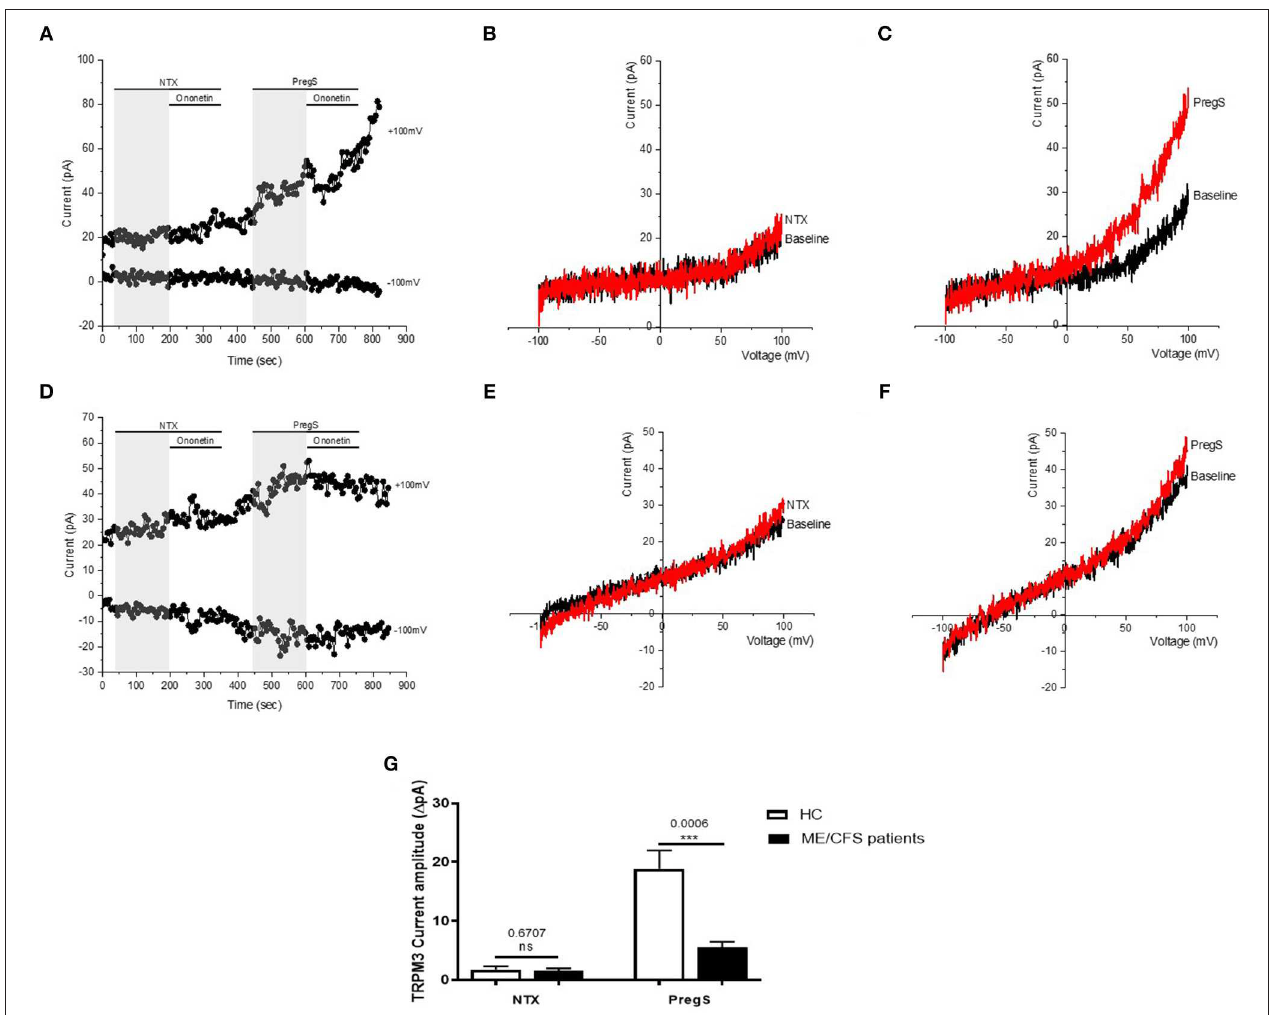
FIGURE 6 | TRPM3 activity after successive applications of NTX and PregS. Data were obtained under whole-cell patch clamp conditions. (A) A representative time-series of current amplitude at + 100mV and − 100mV showing the effect of 100 µ M PregS and 200 µ M NTX (gray) on ionic currents in IL-2 stimulated NK cells from HC. (B) I – V before and after NTX stimulation in a cell corresponding with (A). (C) I – V before and after PregS stimulation in a cell corresponding with (A). (D) A representative time-series of current amplitude at + 100mV and − 100mV showing the effect of 100 µ M PregS and 200 µ M NTX (gray) on ionic currents in IL-2 stimulated NK cells from ME/CFS patients. (E) I – V before and after NTX stimulation in a cell as shown in (D). (F) I – V before and after PregS stimulation in a cell as shown in (D). (G) Bar graphs representing TRPM3 current amplitude at + 100mV after successive applications of 100 µ M PregS in ME/CFS patients ( N = 8 ; n =